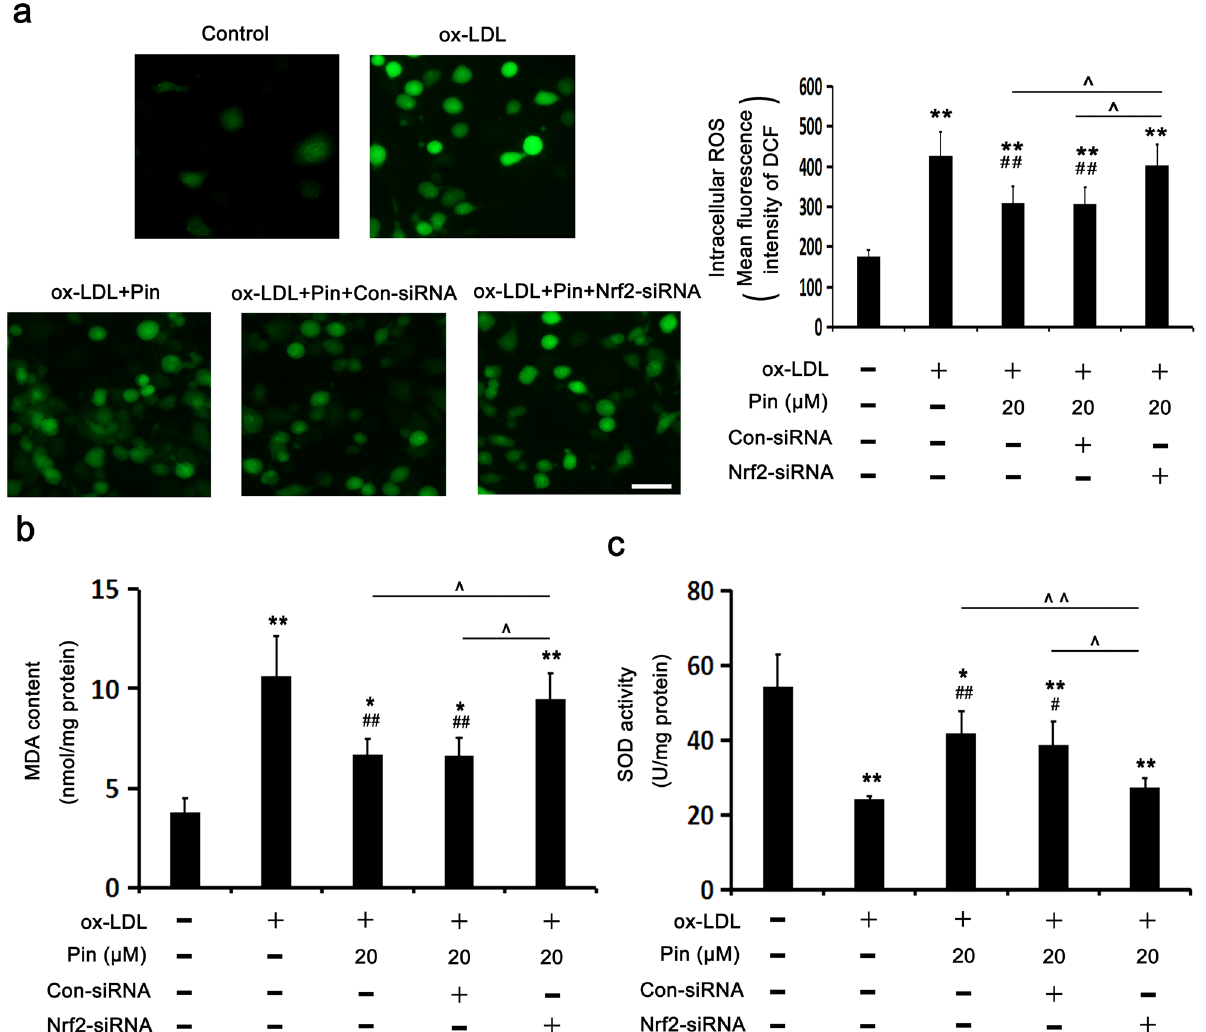
Figure 5. Role of Pin in OxS depends on Nrf2 in oxLDL-challenged HUVECs. HUVECs were transfected with con-siRNA or Nrf2-siRNA, pretreated with or without 20 µM Pin for 2 h and then incubated with 100 mg/L oxLDL for an additional 24 h. ( a ) DCF fluorescence was quantified using a flow cytometer to measure the levels of intracellular ROS and the representative fluorescence images depicting ROS staining. Scale bar = 50 µm. ( b,c